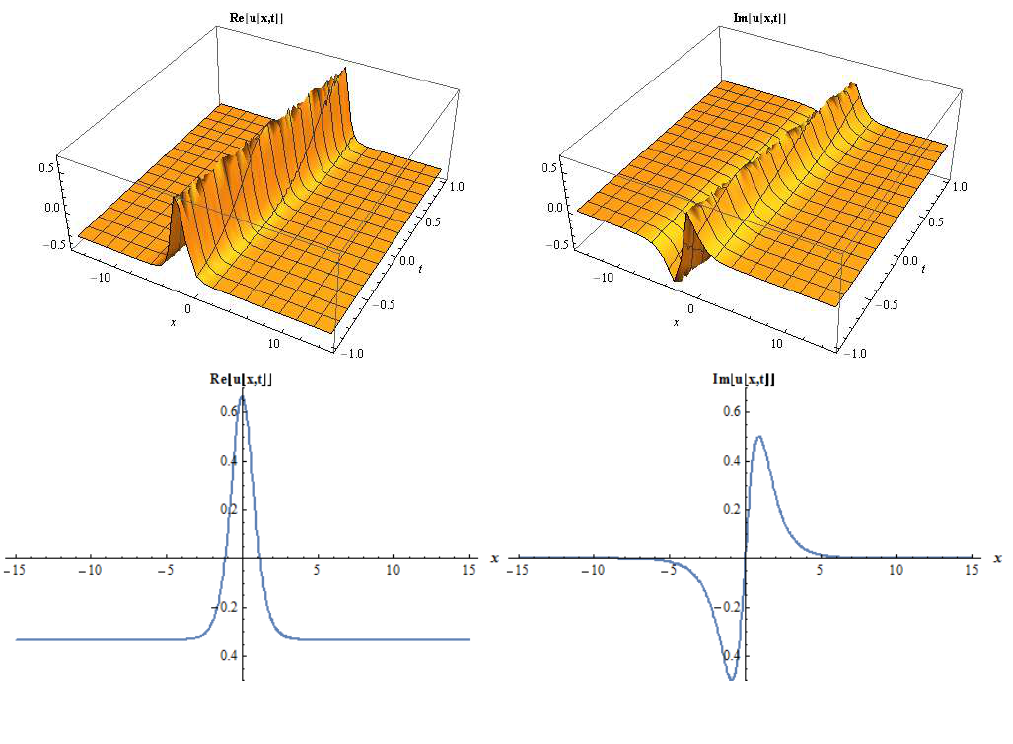
Fig. 3 The 3D and 2D surfaces of Eq.